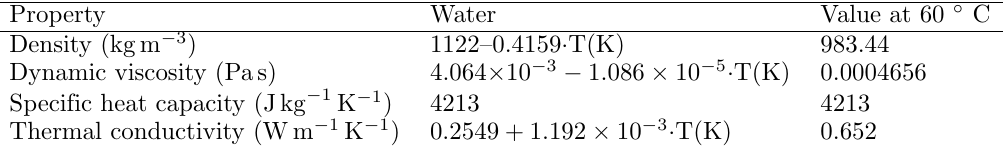
Table 3. Thermo-physical properties of water [7].